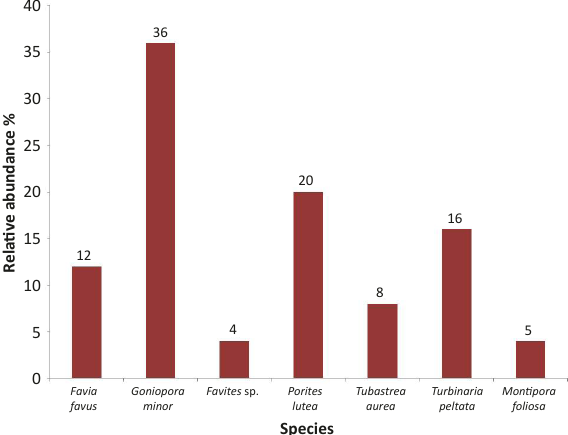
Figure 2. Relative Abundance (%)of coral species in Kuchdi- Porbandar area